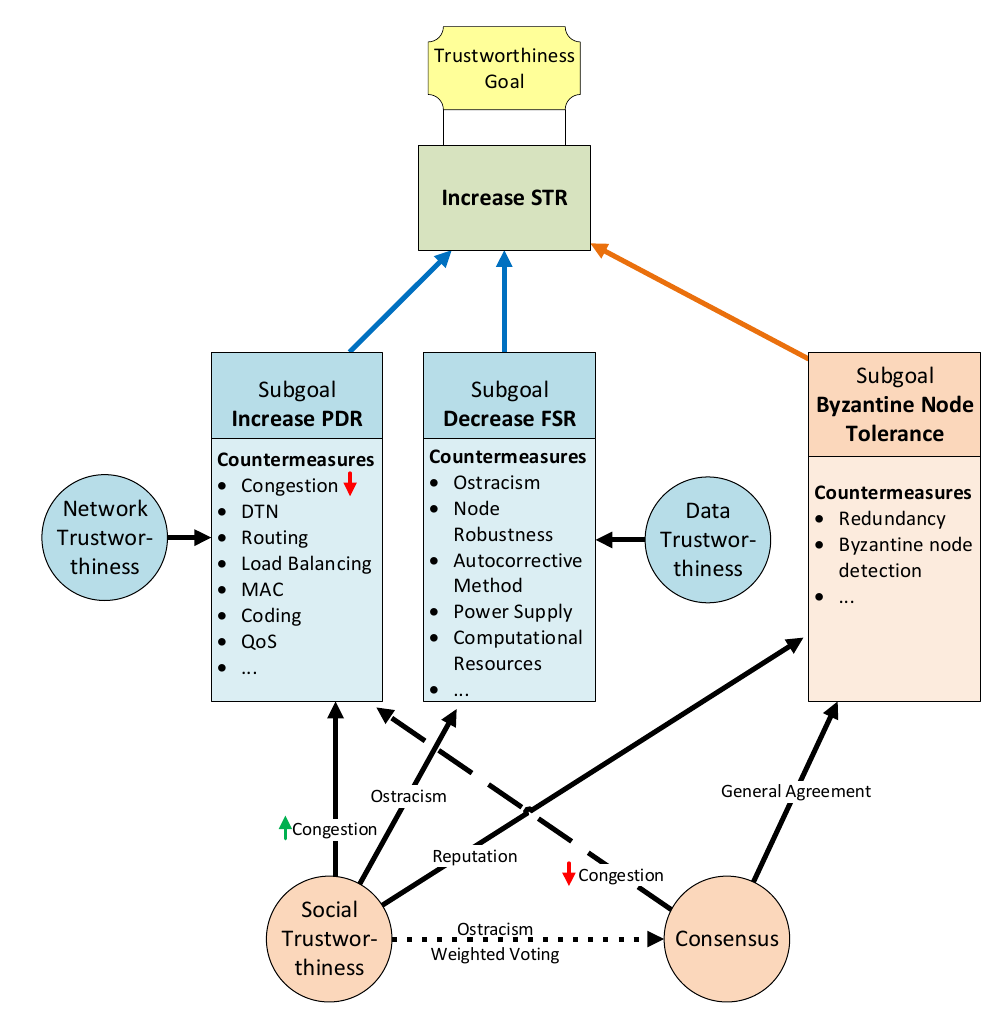
Figure 6. Trustworthiness model goals and countermeasures relationship